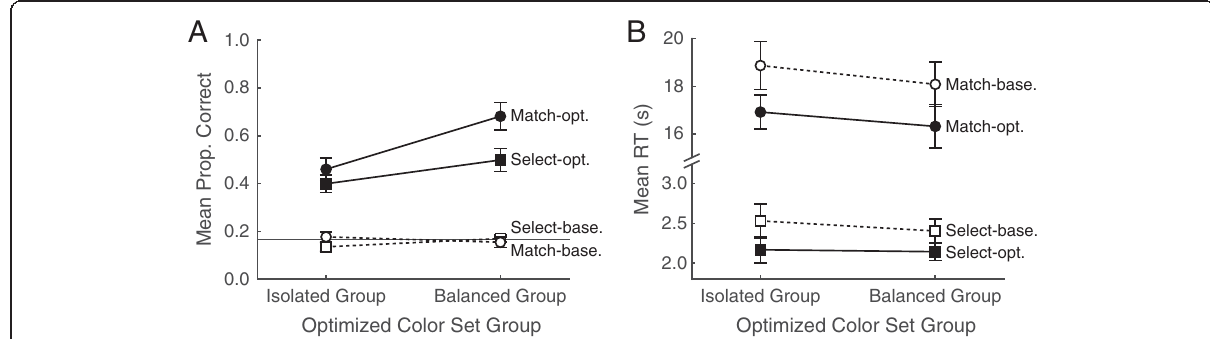
Fig. 10 a Mean proportion of correct responses for the optimized color sets ( closed symbols ) and baseline color sets ( open symbols ) for participants in the isolated group and balanced group ( x-axis ), separated by participants in the match task ( circles ) and select task ( squares ). The horizontal line at 1/6 (approximately 0.17) represents chance. b Mean RTs for the optimized color sets ( closed symbols ) and baseline color sets ( open symbols ) for participants in the isolated group and balanced group ( x-axis ), separated by participants in the match task ( circles ) and select task ( squares ). Note the broken y-axis due to the responses for the select and match tasks being on different time scales. Error bars represent ± the standard errors of the